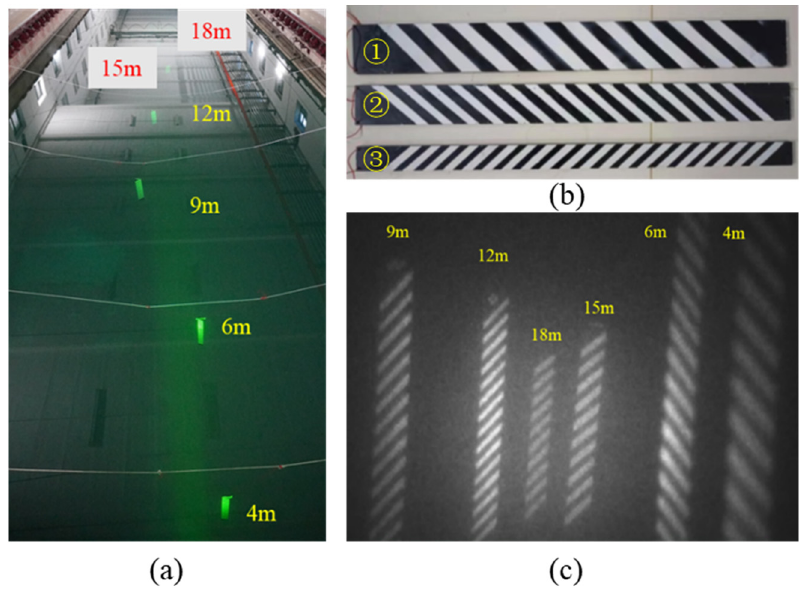
Figure 11. Experiment in MSI method. ( a ) Six targets in experiment; ( b ) Three different sizes of targets; ( c ) Output image of the system.